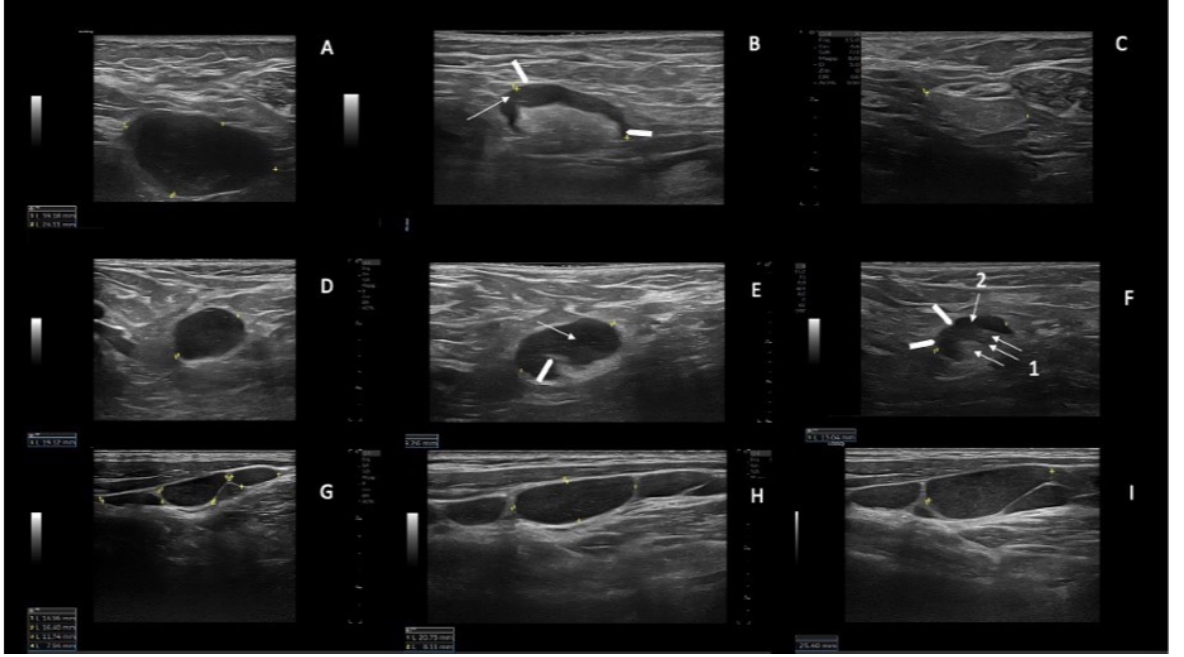
Figure 1. Examples of SupLNs achieving CR, SupLNs in persistent PR, and SupLN in SD. ( A ) Right axillary CLL-LN (39 mm × 24 mm) at baseline (T0). The LN appears hypoechoic, with sharp and regular borders, without a visible hilum, L/S ratio < 2, and with a thickened and reticulated cortex. ( B ) the same LN at T3 (27.3 mm) showing a partial involvement by CLL. The cortex appears inho- mogeneous (the anterior part more thickened than the posterior part-white arrowheads, with retic- ulated cortex-white arrow). The hyperechoic hilum is visible, although irregular. ( C ) the same LN measuring 19.3 mm, has become liposclerotic (nodal CR) at T6. ( D ) Right axillary CLL-LN (19 mm) at T0, with round shape (L/S < 2) showing the same US features as for the LN shown in panel A. ( E ) the same LN at T6 showing a partial involvement by CLL (19.2 mm): US show a visible hilum which is displaced and truncated (white arrowhead 1), the cortex is thickened inhomogeneous, with retic- ulation (white arrow). ( F ) the same LN at T15 (13 mm) showing a persistent partial CLL involvement of the LN: the cortex is still not homogeneously thickened, which determines irregular borders of the LN (white arrowheads) and irregular shape of the hilum (white arrow 1) which appears dislo- cated in the posterior part of the LN. The cortex shows reticulation (white arrow 2). ( G ) left latero- cervical CLL-LN in SD at T0. ( H ) left laterocervical CLL-LN in SD at T12. ( I ) Left laterocervical CLL- LN in SD at T24. The SupLNs present “chain”-shaped, contiguous, sharp borders without US visible hilum. The cortex is inhomogeneous and thickened, with reticulation.